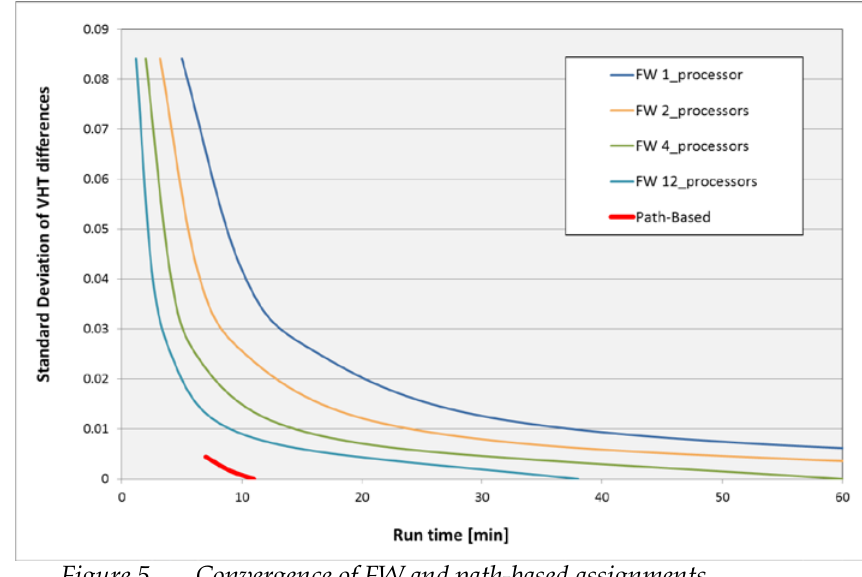
Figure 5. Convergence of FW and path-based